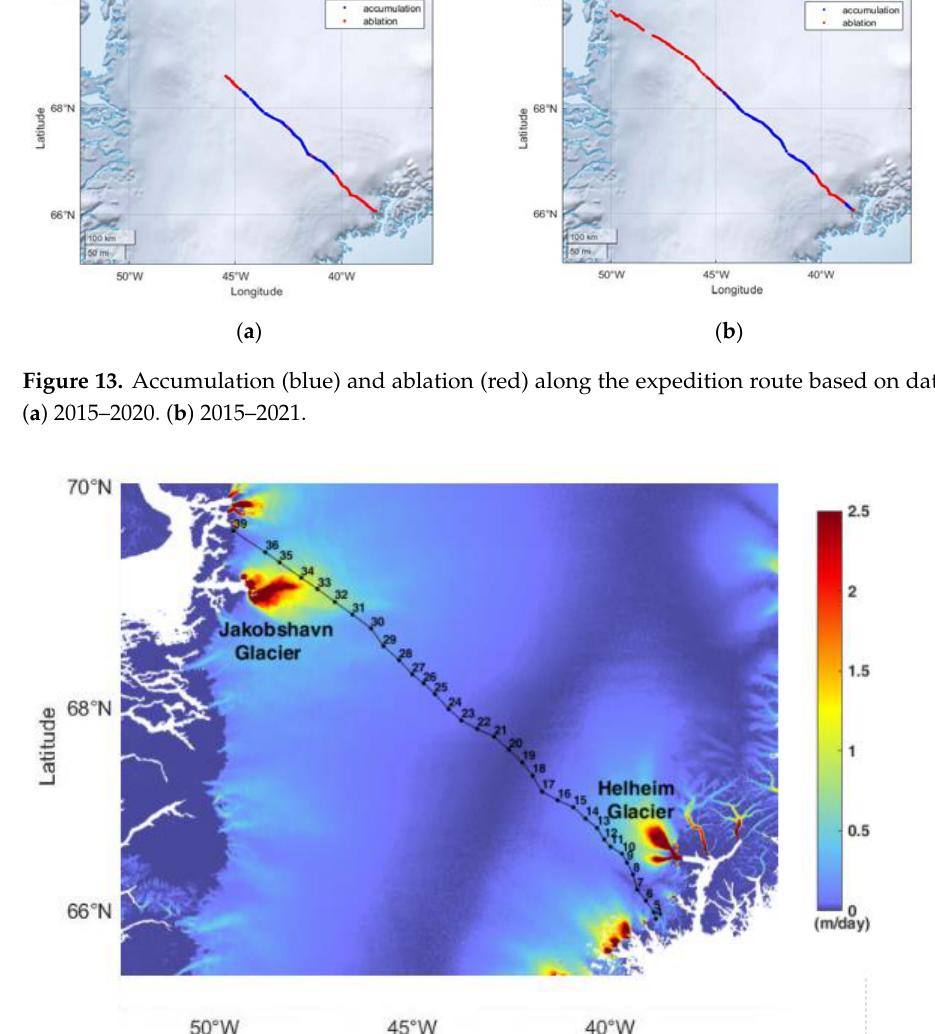
Figure 12. Comparison of crossing points along the expedition route with modified elevation change at the west coast. Blue color = 2020; orange color = 2021.